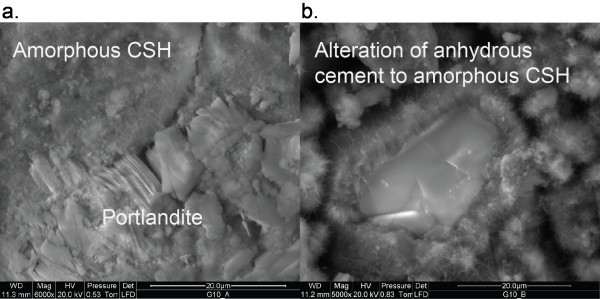
ESEM images of Class G cement reacted in 0.13 molal CaCl2 solution showing crystalline portlandite, residual anhydrous Ca2SiO4 and amorphous CSH.